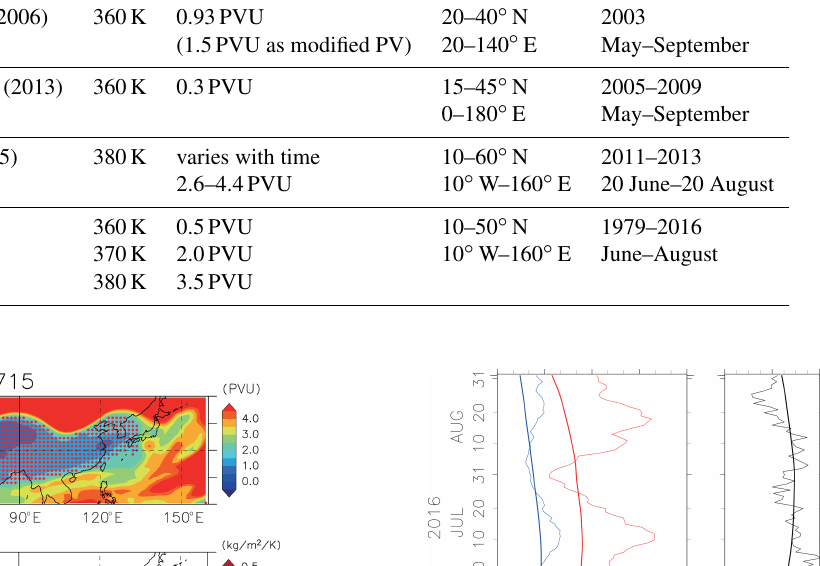
Table 1. Overview of the method of this study and previous studies which define the AMA based on the area enclosed by PV contours. θ PV